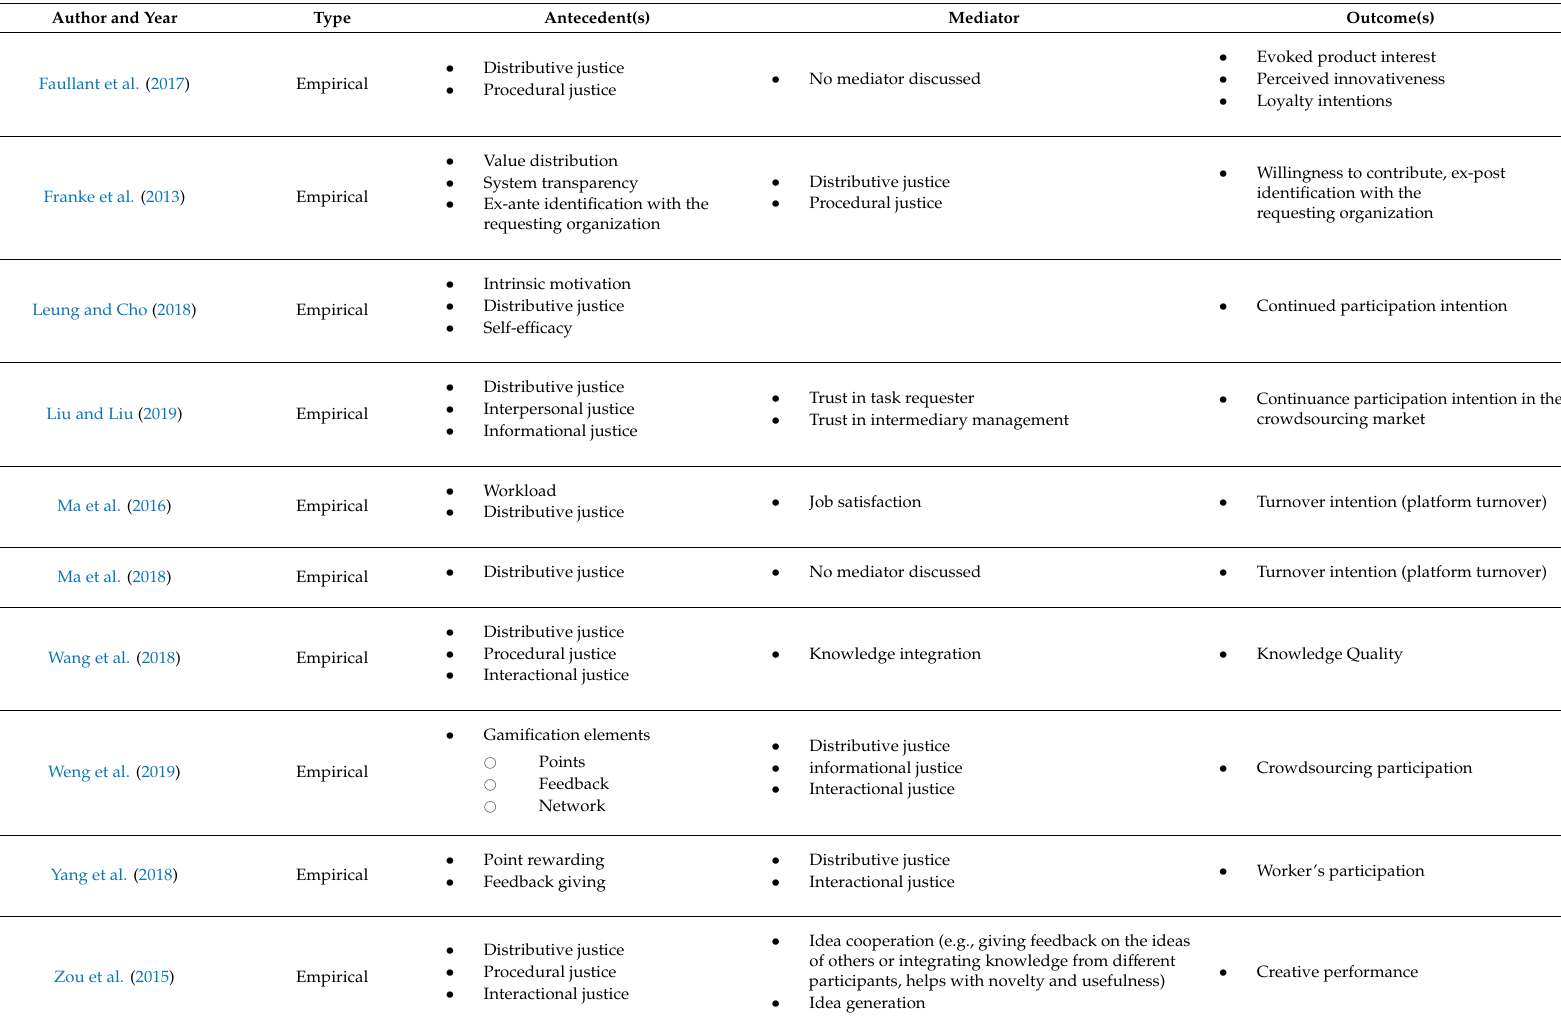
Table 3. Literature Review of Organization Justice in Crowd-based Context (in alphabetical